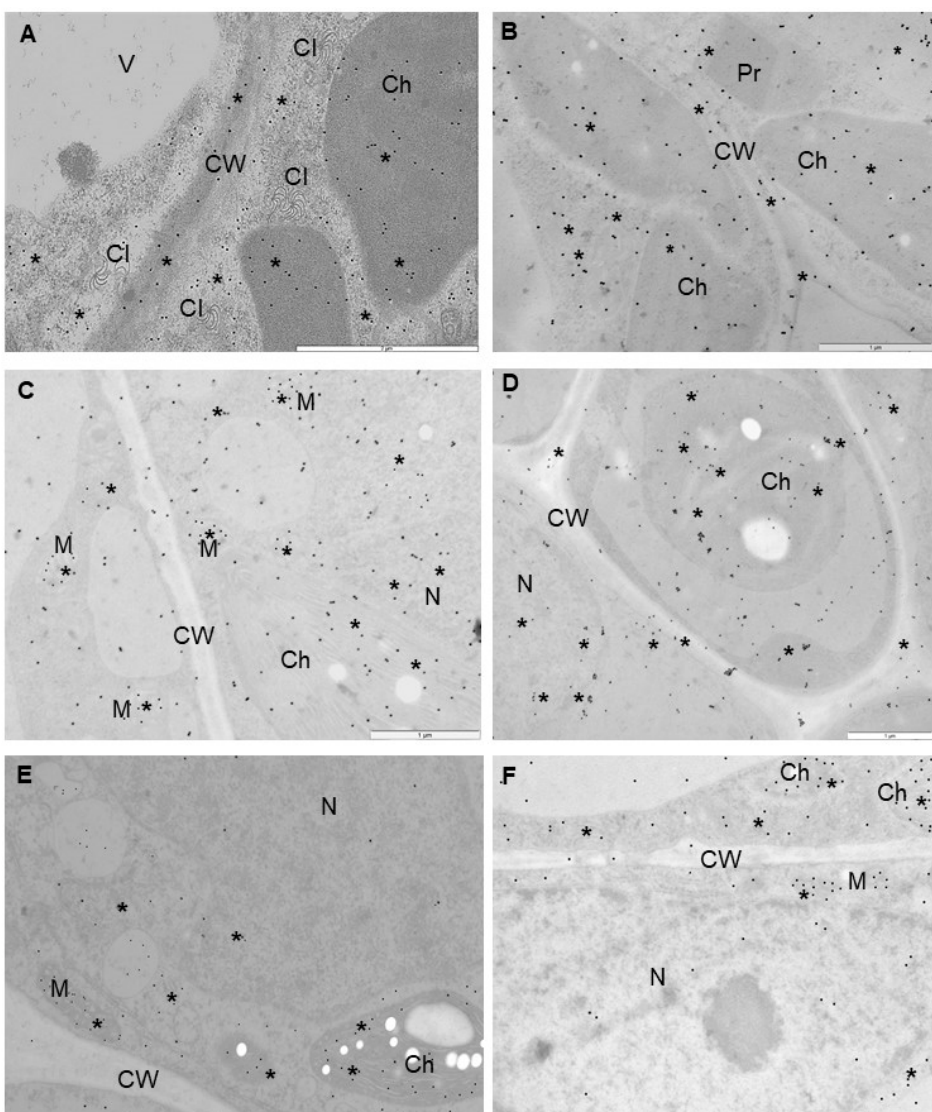
Figure 6. Immunogold labeling of glutathione content in the leaves of PVY and mock inoculated susceptible Irys ( A , B , E ) and Neptun ( C , D , F ) potato plants at 7 dpi. ( A ) Glutathione (*) in chloroplast (Ch) and cytoplasm in pallisade mesophyll cell. Virus cytoplasmic inclusions (CI) presented near the cell wall (CW). Bar = 2 μ m. ( B ) Glutathione (*) in chloroplast (Ch) and cytoplasm in spongy mesophyll cell. Gold deposition also found in cell wall (CW) and peroxisomes (Pr). Bar = 1 μ m. ( C ) Gold granules (*) indicated glutathione in mitochondria (M), chloroplast (Ch), and nucleus (N) in Neptun potato mesophyll cells. Bar = 1 μ m. ( D ) Glutathione (*) in chloroplast (Ch) and nucleus (N) in Neptun potato phloem parenchyma cells. Gold granules also present in cell wall. Bar 1 = μ m.( E ) Glutathione localization in chloroplast (Ch), mitochondria (M), and cytoplasm in phloem of potato Irys mock inoculated cells. Bar = 2 μ m. ( F ) Glutathione localization in chloroplast (Ch), mitochondria (M), and cytoplasm in the phloem of potato Neptun mock inoculated cells. Bar = 2 μ m.